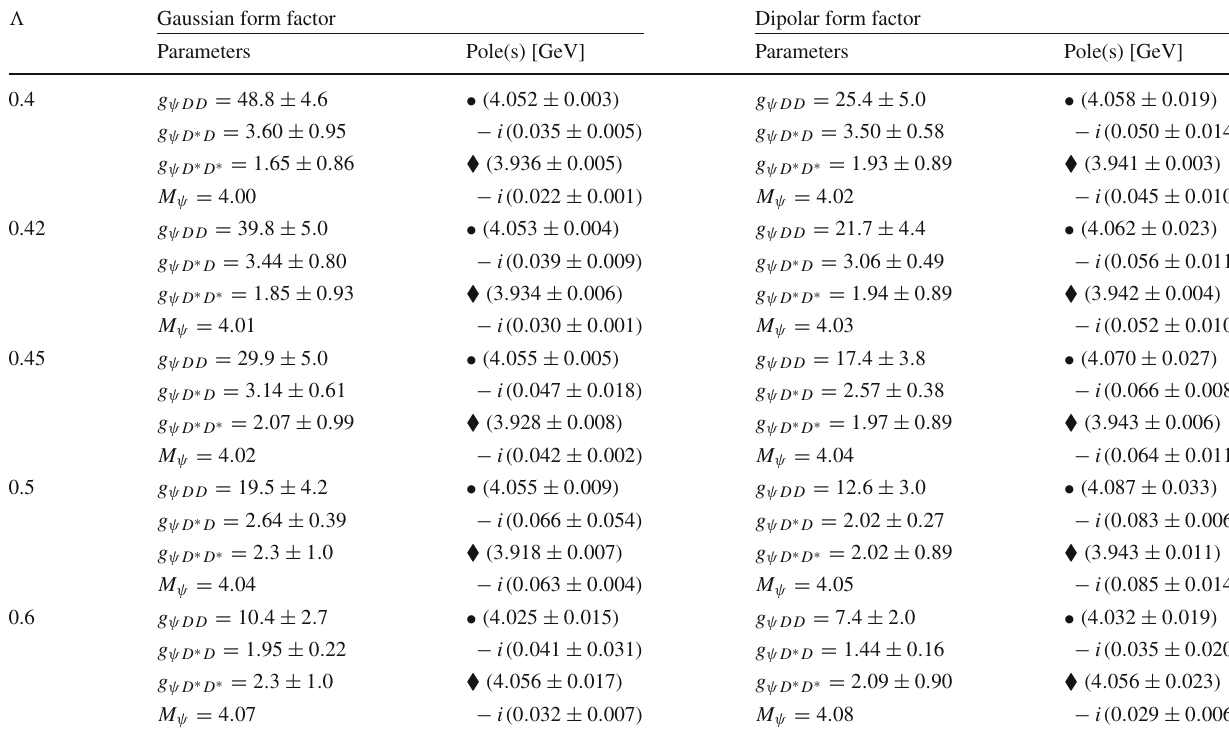
Table 1 Position of the poles in the complex plane for different parameters used in the model. The coupling constants g ψ DD and g ψ D ∗ D ∗ are dimensionless, g ψ D ∗ D has dimensions GeV − 1 , (cid:11) and M ψ are in